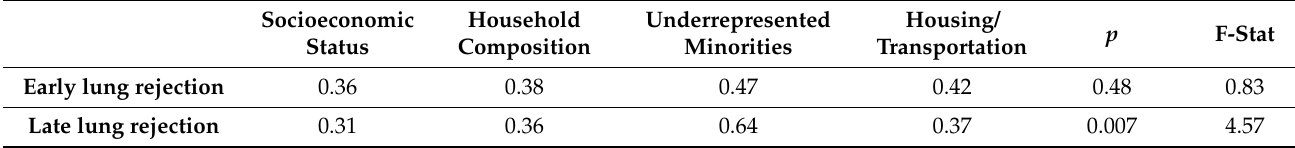
Table 2. Centers for Disease Control Social Vulnerability